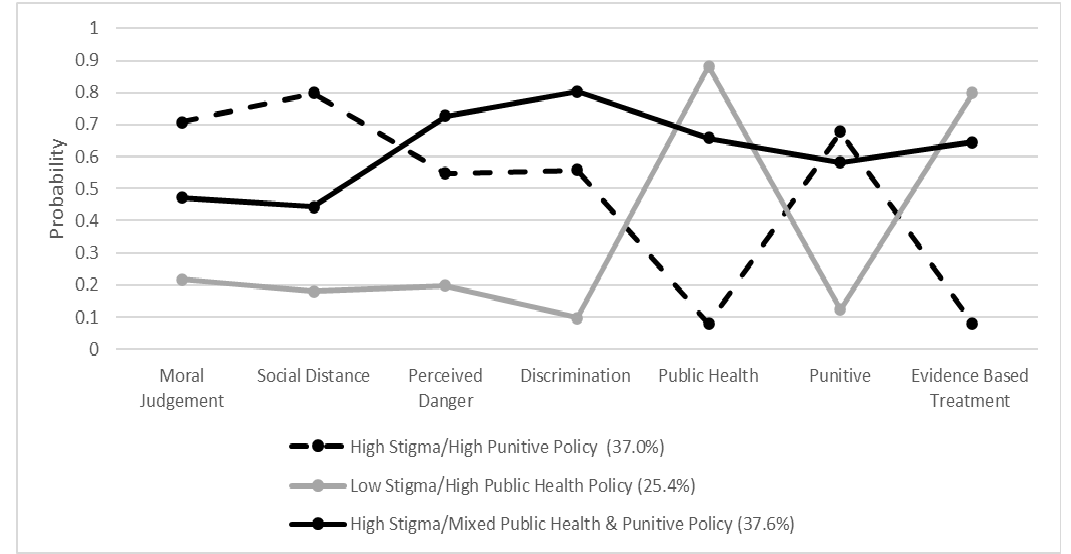
Figure 2. Latent Classes of Opioid Stigma and Policy Beliefs: results from the nationally representa- tive AmeriSpeak survey, February 2020. AmeriSpeak survey, February